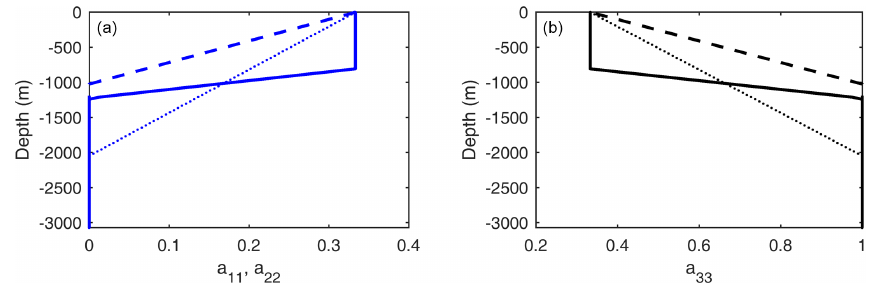
Figure 2. Fabric as a function of depth (at Kunlun station) for girdle fabric with z s = 1 / 3 (dashed curve) and z s = 2 / 3 (dotted curve), and Kunlun fabric (solid curve). The values of a 11 (equals a 22 ) are in blue in (a) , while a 33 is in black in (b) . For single maximum a 11 = a 22 = 0, a 33 = 1; and for isotopic ice a 11 = a 22 = a 33 = 1 . 3 over time and is not a linear function of temperature.